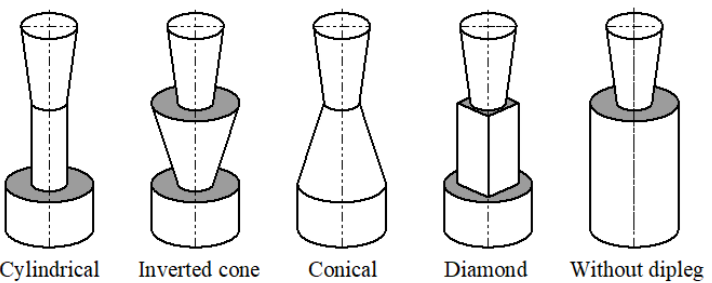
Figure 19. Different shapes of dust reservoirs (dipleg) of cyclones. Figure made by author based on data from paper [83].